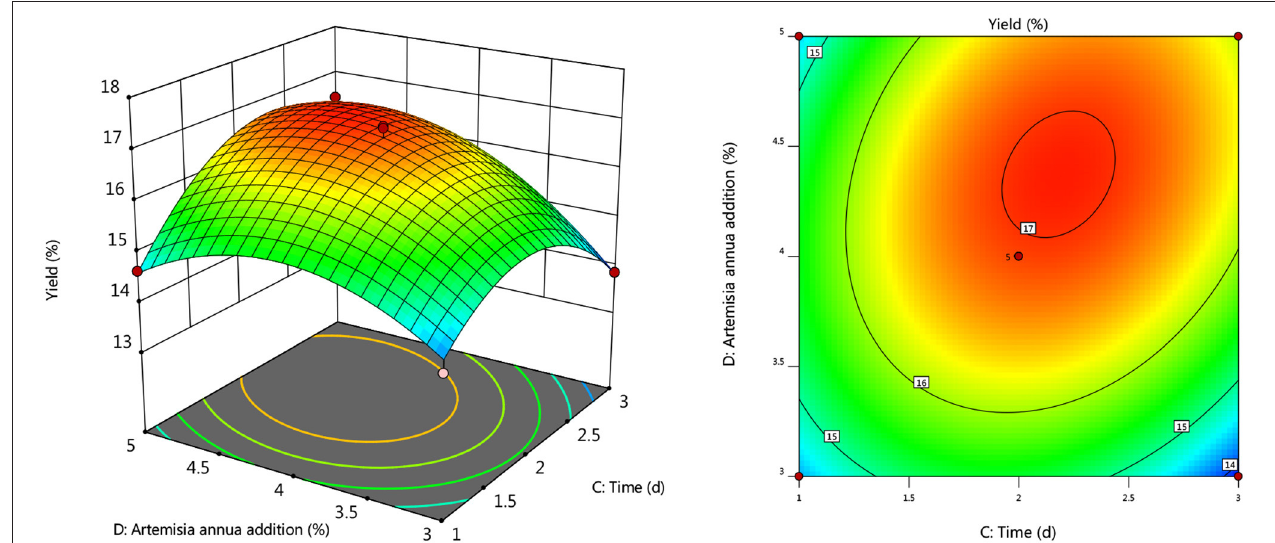
FIGURE 11 | Response plot of the interaction between time and Artemisia annua addition on yield.